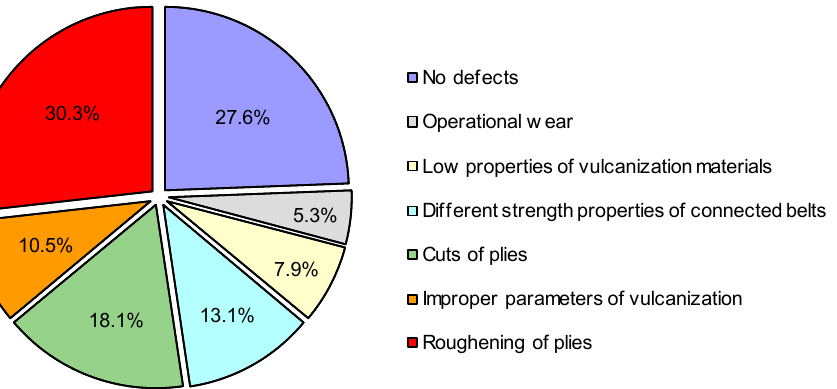
Figure 1. Percentage share for the reasons behind the lowered strength of splices in multiply conveyor belts [25].